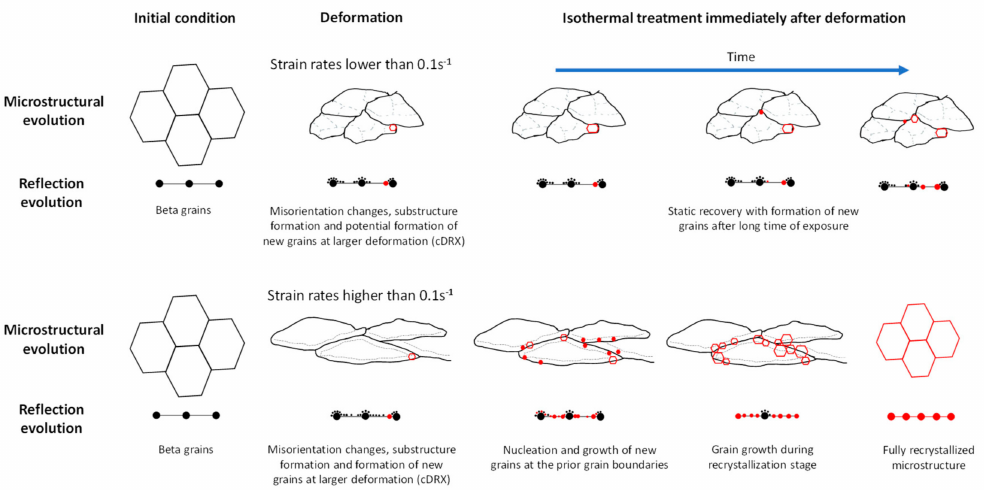
Figure 11. Summary of the microstructural evolution during the studied thermomechanical process and its correlation with the reflections obtained from the β